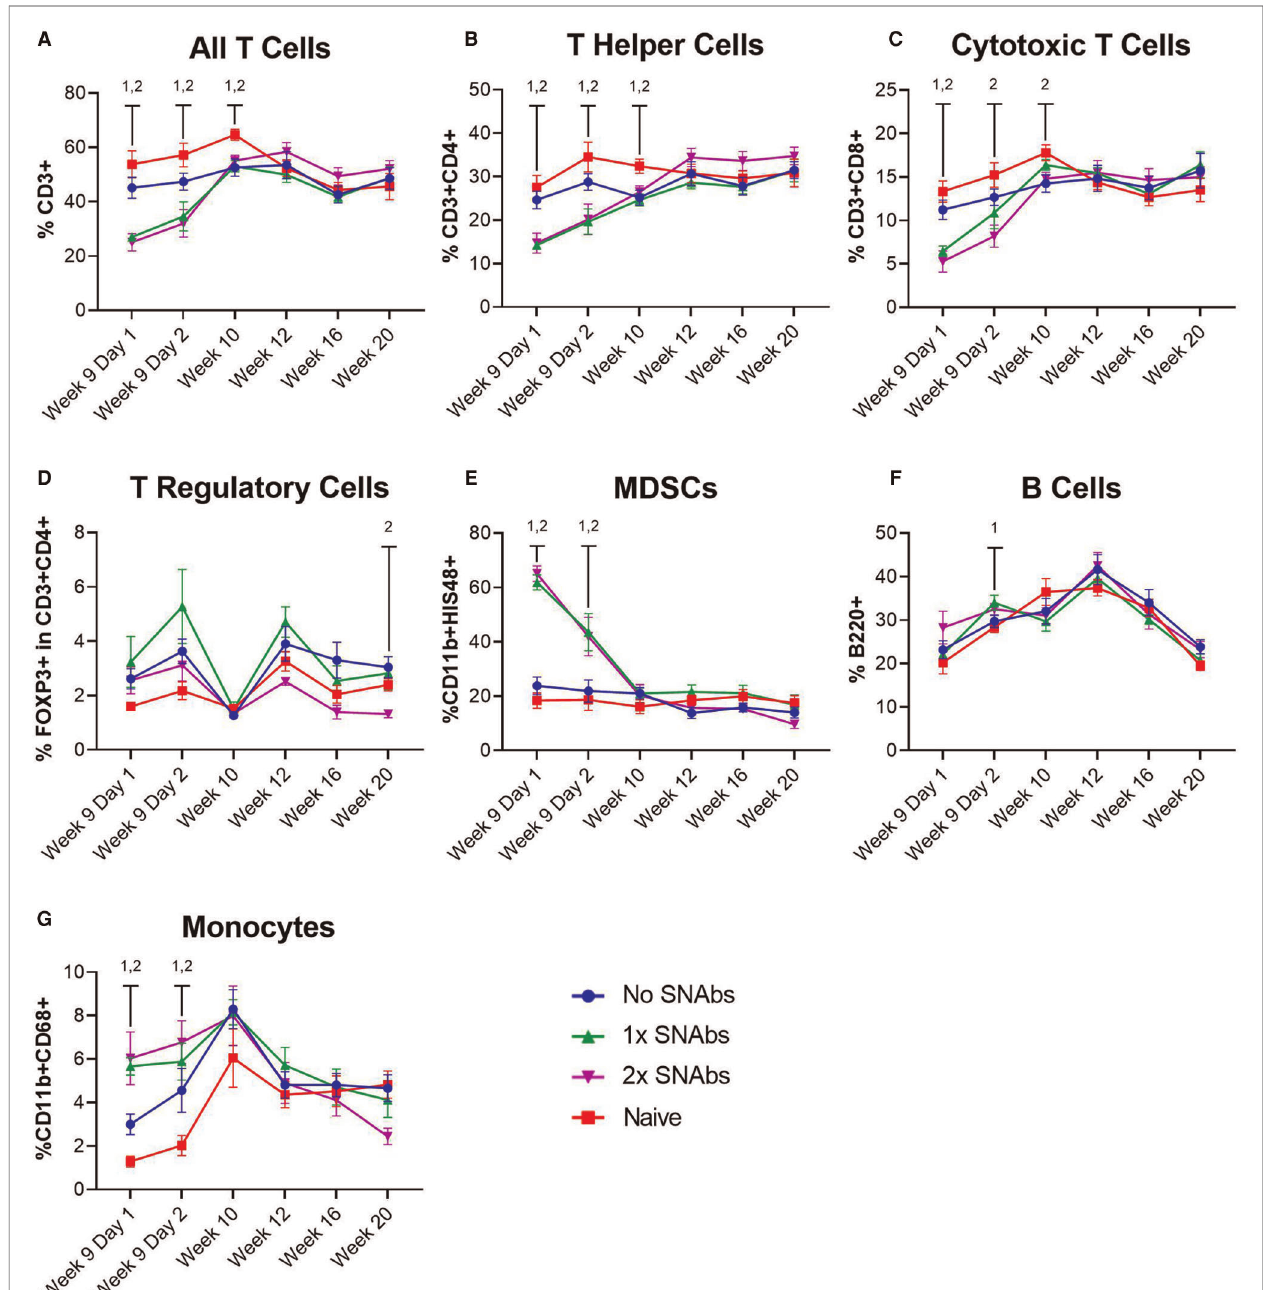
FIGURE 3 | Characterization of circulating immune cells after treatment with synthetic nanoparticle antibodies (SNAbs). ( A – G ) Signi fi cant changes in immune cell populations were observed in rats at multiple timepoints after SNAb injections. T cells, T helper cells, and cytotoxic T cells were signi fi cantly decreased in SNAb- injected rats ( A – C ), while MDSCs and monocytes were signi fi cantly elevated ( E,G ). Data are mean±SEM, n =7 to 13 per group. 1,2 correspond to signi fi cant differences between the naive group and the 1x SNAbs group (1) or the 2x SNAbs group (2), with P